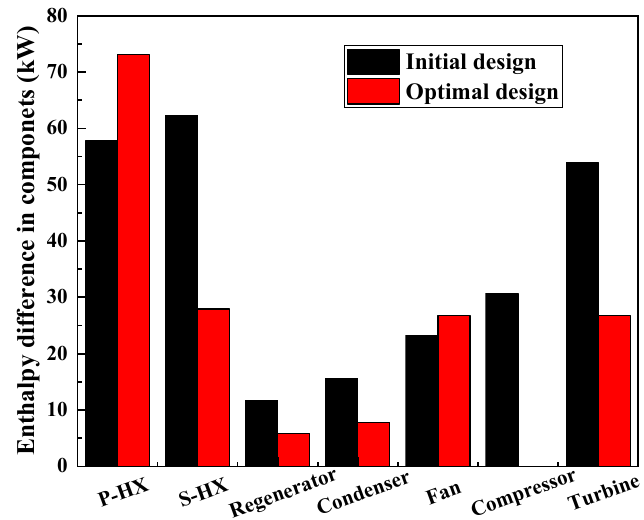
Figure 10. Enthalpy differences in ECS components.